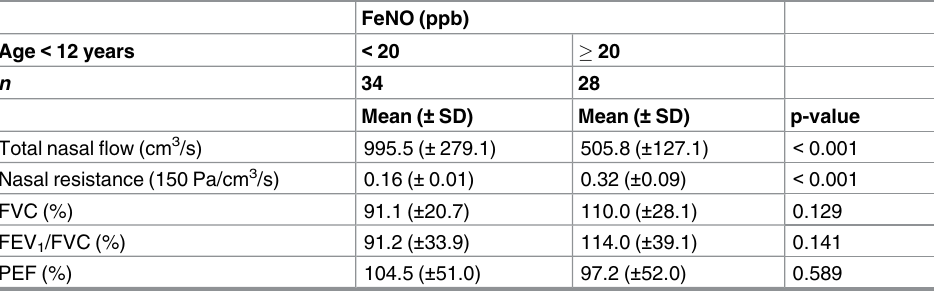
Table 4. Spirometric and rhinomanometric measurements in patients aged < 12 years.